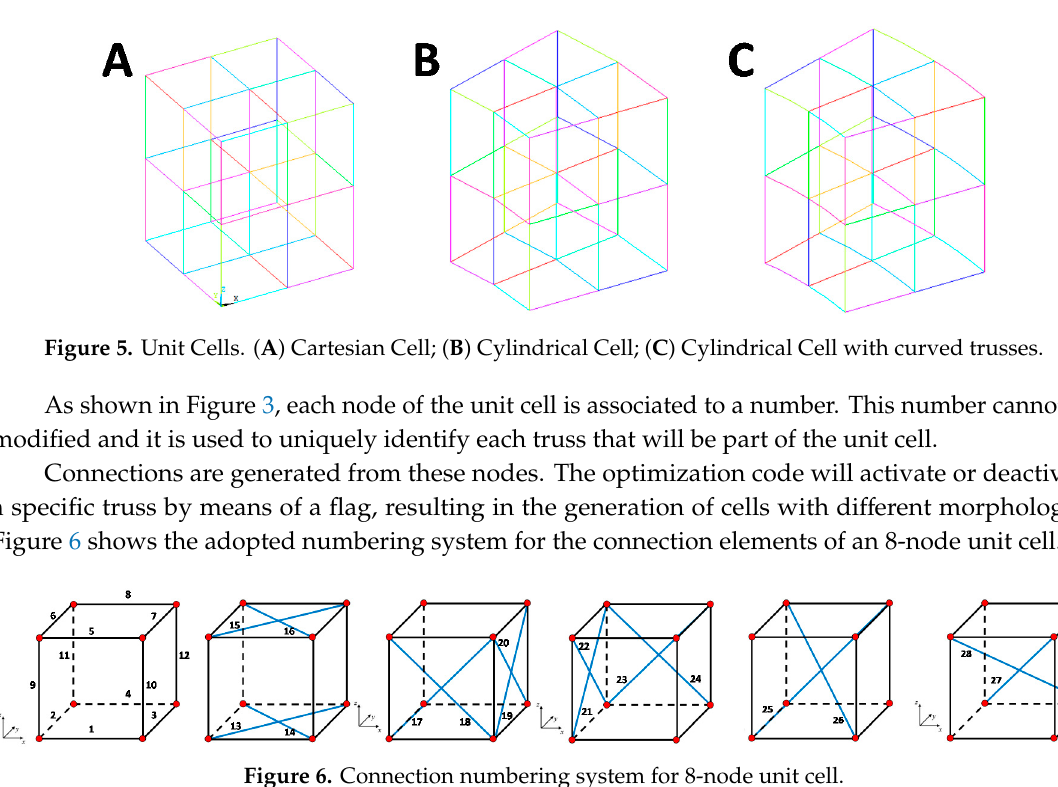
Figure 6. Connection numbering system for 8-node unit cell.